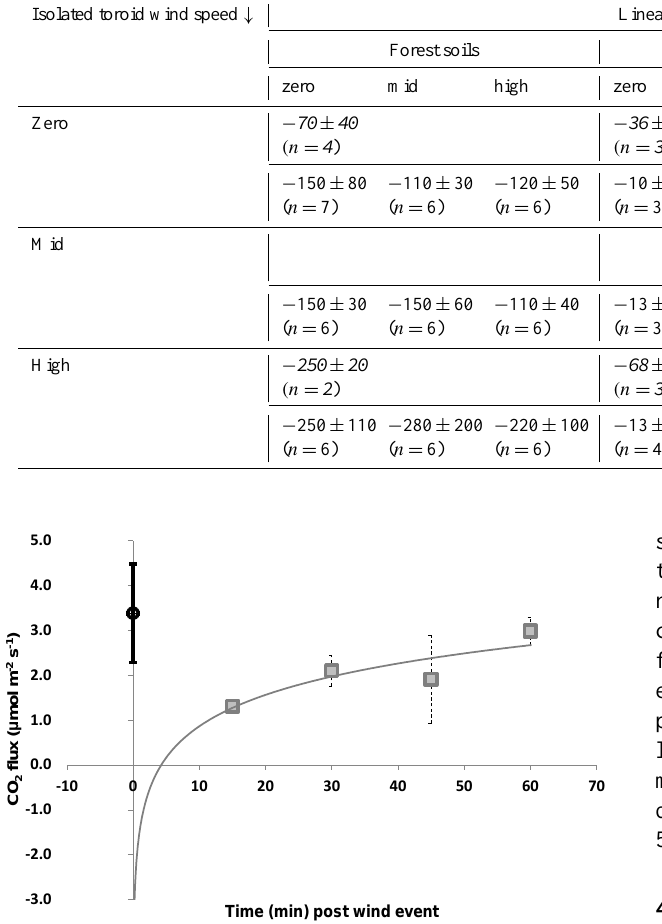
Figure 5. Flux recovery from peat soils after high wind events. Open circle ( ◦ ) represents fluxes taken under zero-wind conditions prior to wind events. Grey squares ( (cid:4) ) represent fluxes measured under zero-wind conditions after wind events. The logarithmic trend line indicates best fit to data ( y = 1 . 01 × ln( t (min)) − 1.46; r 2 = 0 . 77). Error bars indicate standard deviation; n ≥